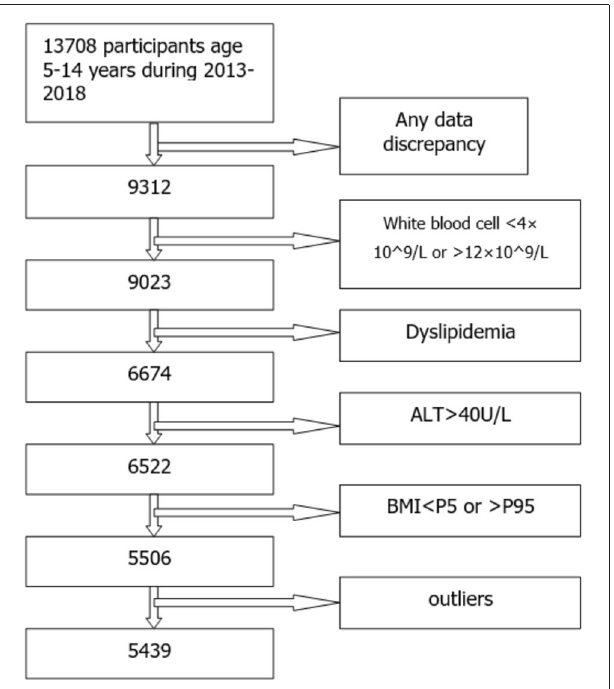
FIGURE 3 | The distribution of uric acid in